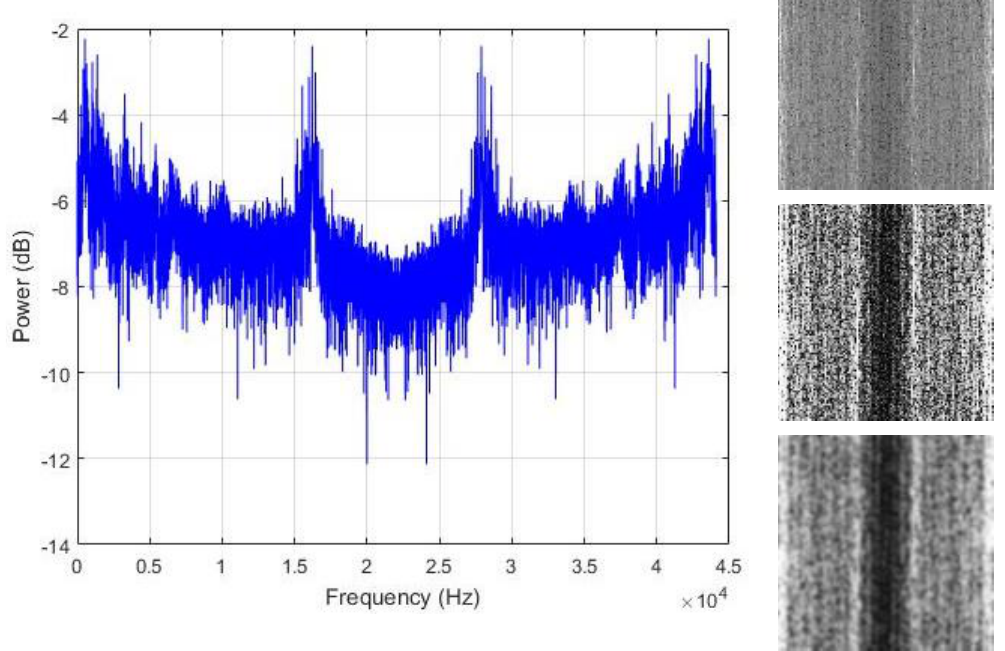
Figure 8. Left column: the power spectrum of a normal data sound; right column: the corresponding PSD-images. From top to bottom: the original image, the histogram equalized and the smoothed versions, respectively. The original size of the PSD-images shown here is 115 × 115.